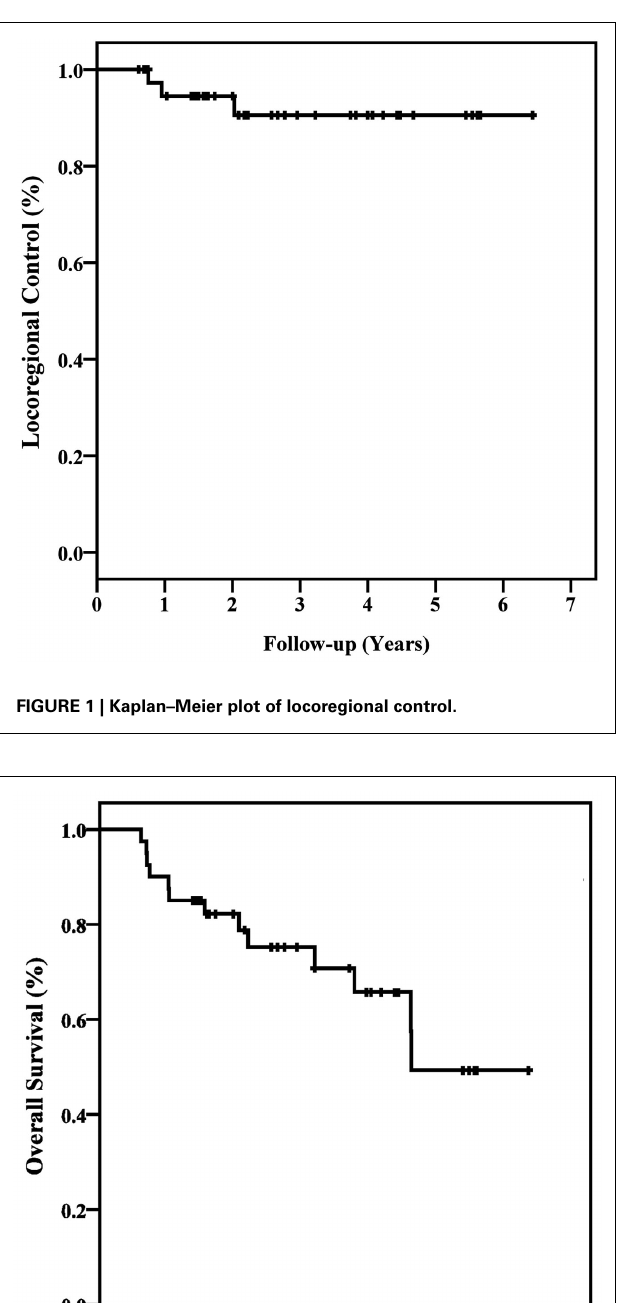
inferior in the SBRT group (72 vs. 87%) conceivably enhancing SBRT’s locoregional